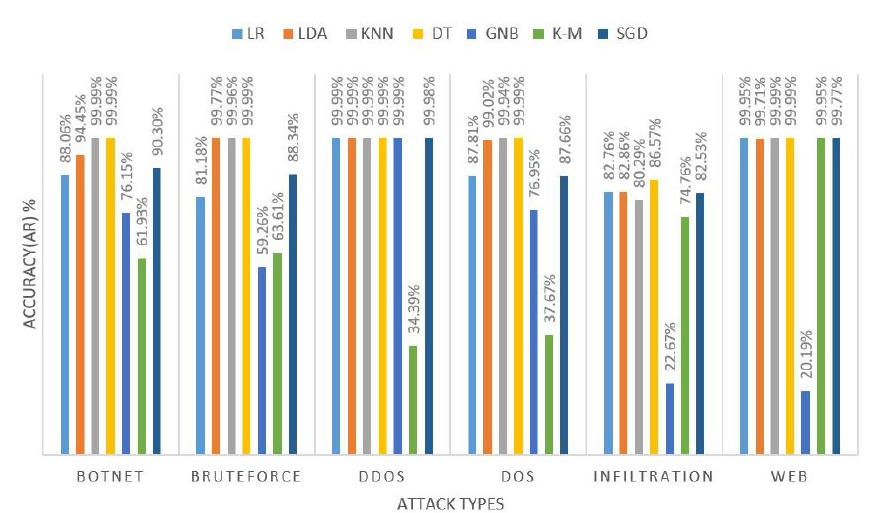
Figure 11. Accuracy of different ML approaches based on various attack types.